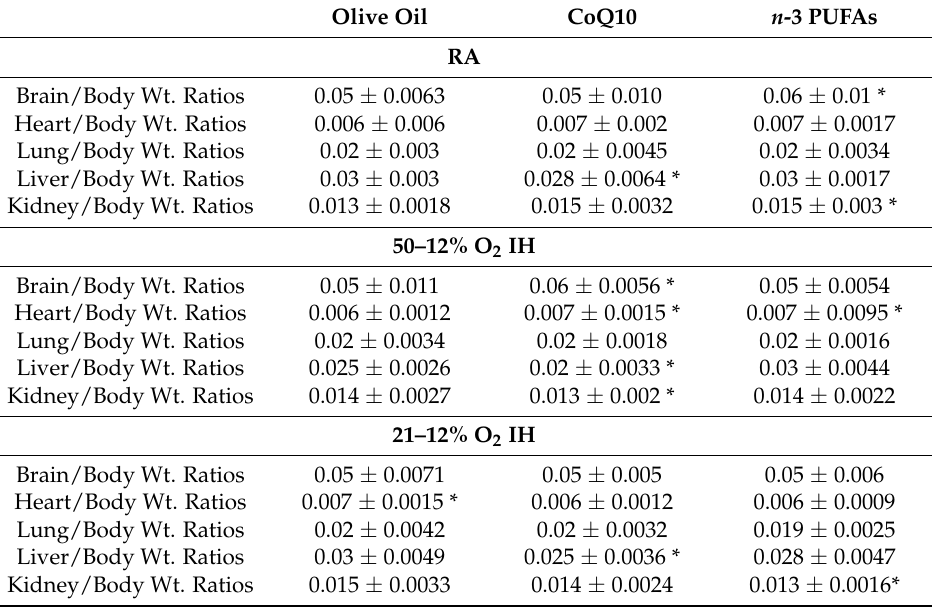
Table 1. Organ Weight at